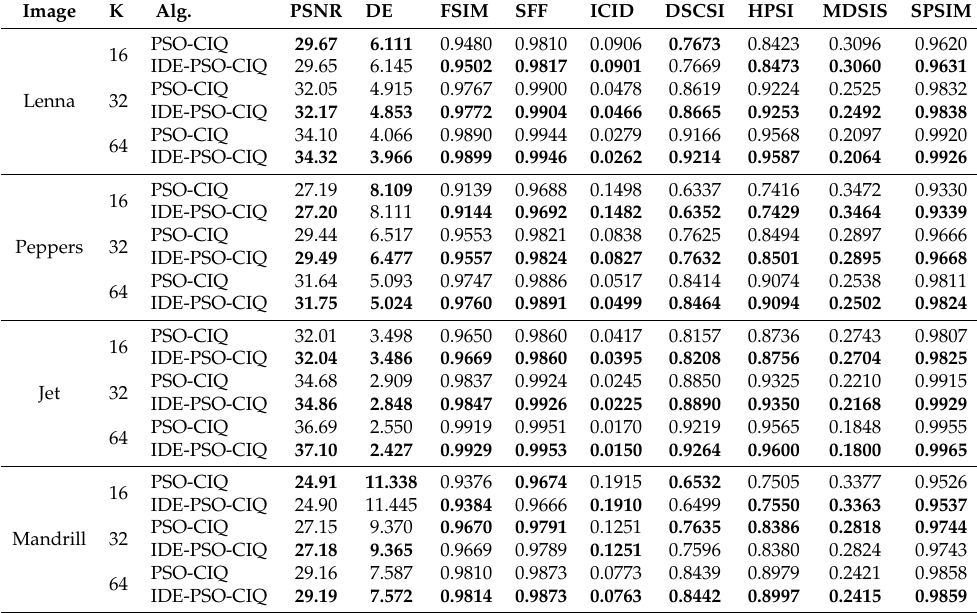
Table 2. Multi-index quality evaluation: PSO-CIQ vs. IDE-PSO-CIQ.